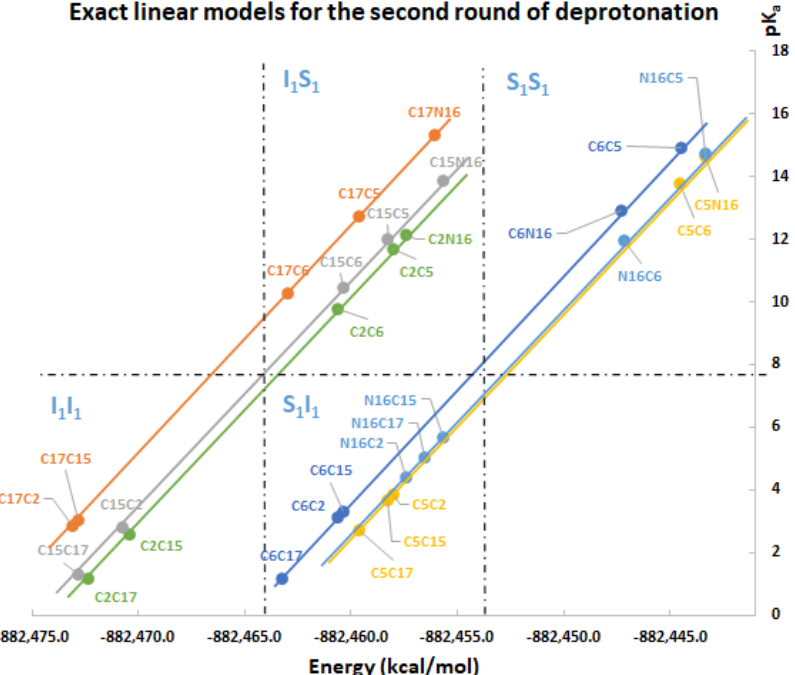
Figure 13. pK a calculation used a direct approach for the second round of deprotonation. Four subclusters are formed: I 1 I 1 , S 1 I 1 , I 1 S 1 , and S 1 S 1 .